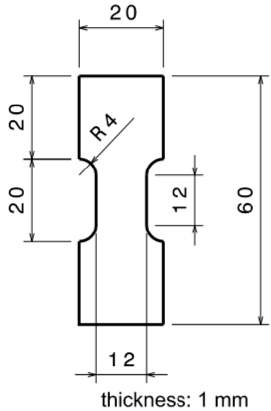
Figure 1. Traction sample geometry (mm).